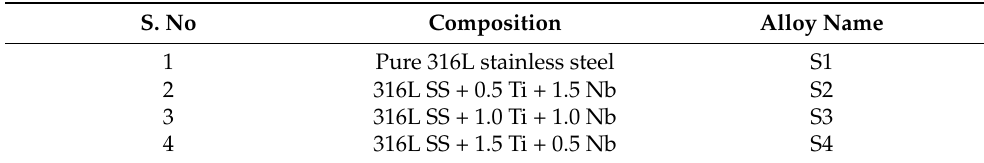
Table 2. Alloy compositions used in this study.